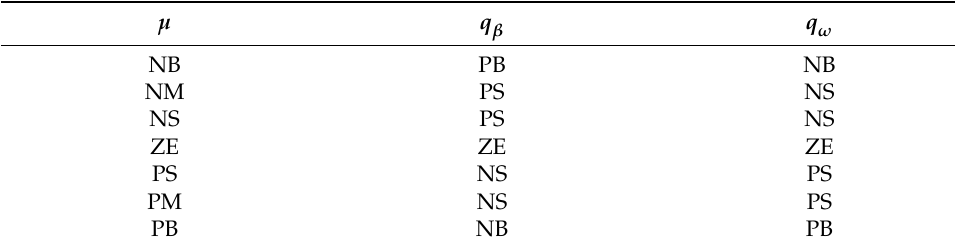
Table 7. Fuzzy Inference Rule.